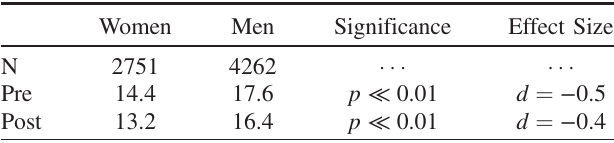
TABLE IV. Overall E-CLASS scores (points) for men and women in the full, aggregate data set ( N ¼ 7013 ) on both the pre- and post-tests. Significance indicates the statistical significance of the difference between women ’ s and men ’ s scores.